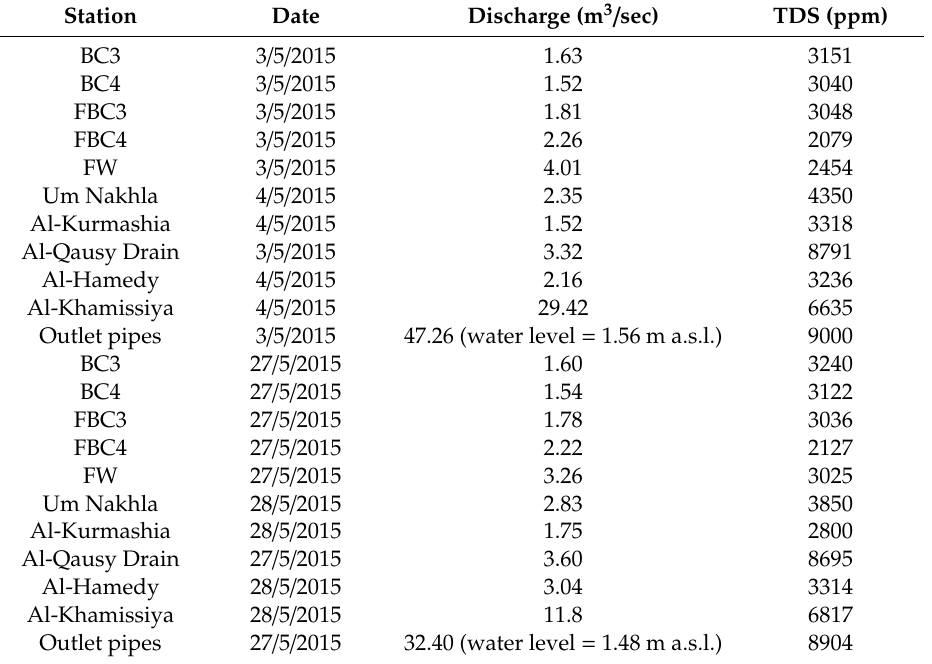
Table 5. Discharge and TDS at the inlets and outlet of marsh (measured during the period from 3 May 2015 to 28 May